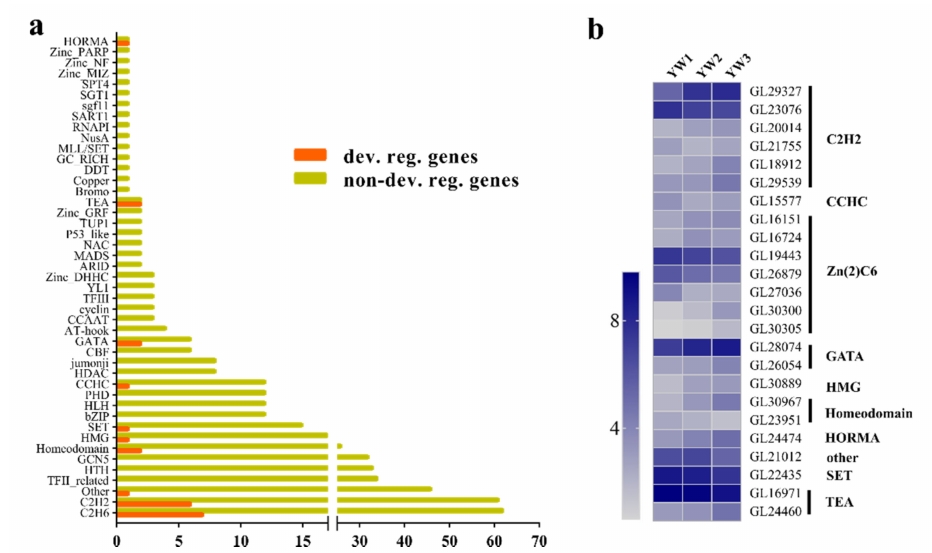
Figure 5. Expression of genes coding for transcriptional regulators. ( a ) Transcriptional regulator family distribution and the proportions of developmentally regulated (orange) versus non-regulated (yellow) genes. ( b ) Heatmap of developmentally regulated transcription factor (TF)-coding genes. The square represents log 2 (FPKM + 1) ratio of the transcript abundance change in different stages.